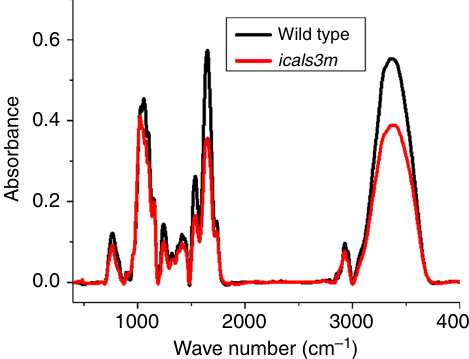
Fig. 9 Fourier-transform infrared analysis of cell walls 24 h after estradiol treatment. The image shows an example of the FTIR pro fi le for one replica per each genotype: wild type (black trace) and transgenic line pG1090 :: icals3m ( icals3m , in red). Estradiol-treated icals3m accumulates callose in comparison to control (Fig. 8 and Supplementary Fig. 9). Notice that the absorbance of the OH- stretching vibration broad band (3100 – 3600 cm − 1 ) is reduced in